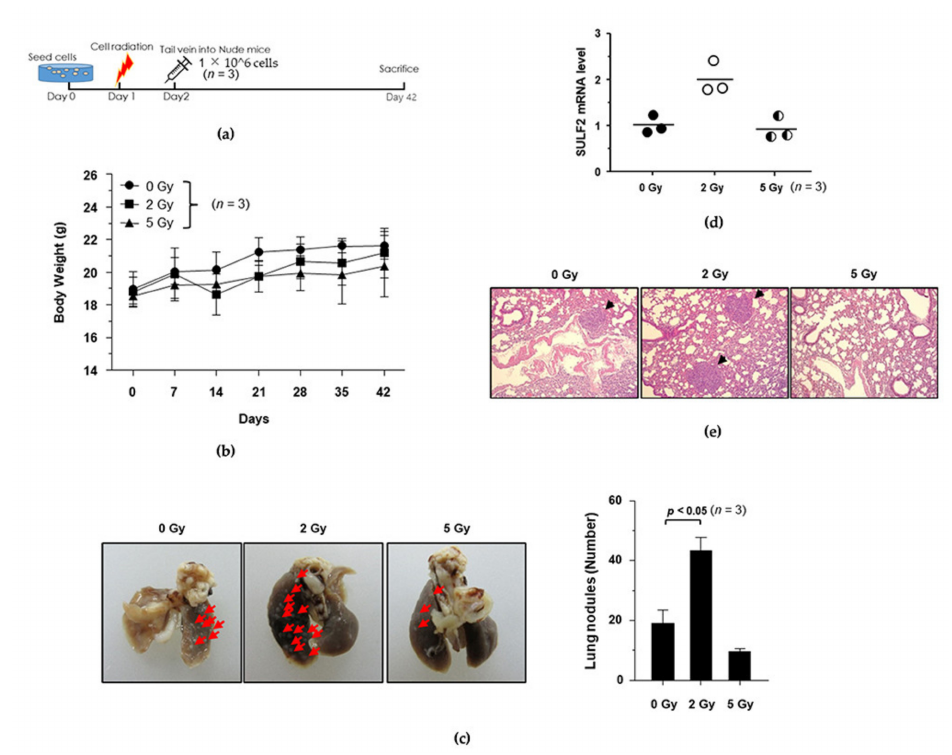
Figure 4. Establishment of a mouse model of IR-induced metastasis. ( a ) Schematic diagram of the experimental design for establishing the mouse model of IR-induced metastasis. ( b ) Changes in mouse body weights. ( c ) Representative gross lung images. Red arrows indicate metastatic nodules. ( d ) SULF2 mRNA levels in lung tissues were compared using qRT-PCR. ( e ) H&E staining of lung specimens. Black arrows indicated metastatic nodules.